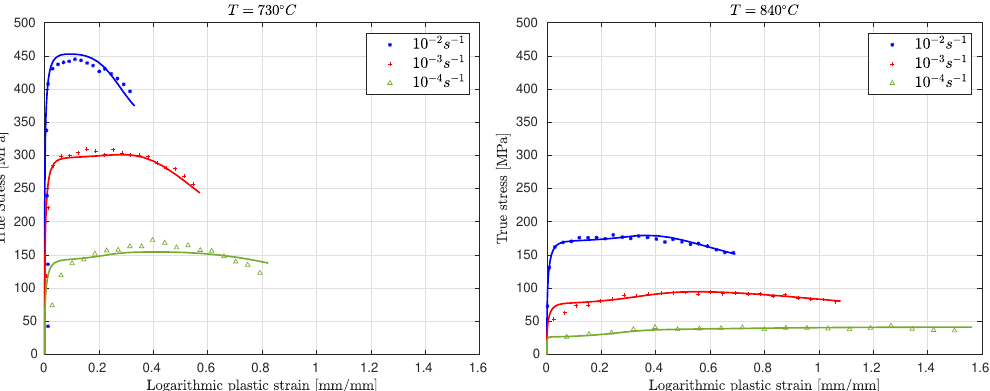
Figure 9. Comparison between experimental and computed stress-strain curves at 730 ◦ C and 840 ◦ C for several strain rate conditions (Model predictions: lines; Experiment: